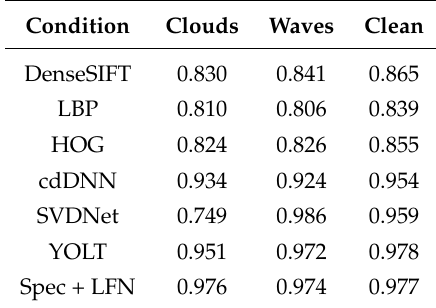
Figure 10. Precision-recall curves of six different feature descriptors: HOG, LBP DenseSIFT, SVDNet, cdDNN, YOLT, and Spec+LFN; for definitions of abbreviations, see Section 5.5. Table 5. F1-measurement of performance on experimental